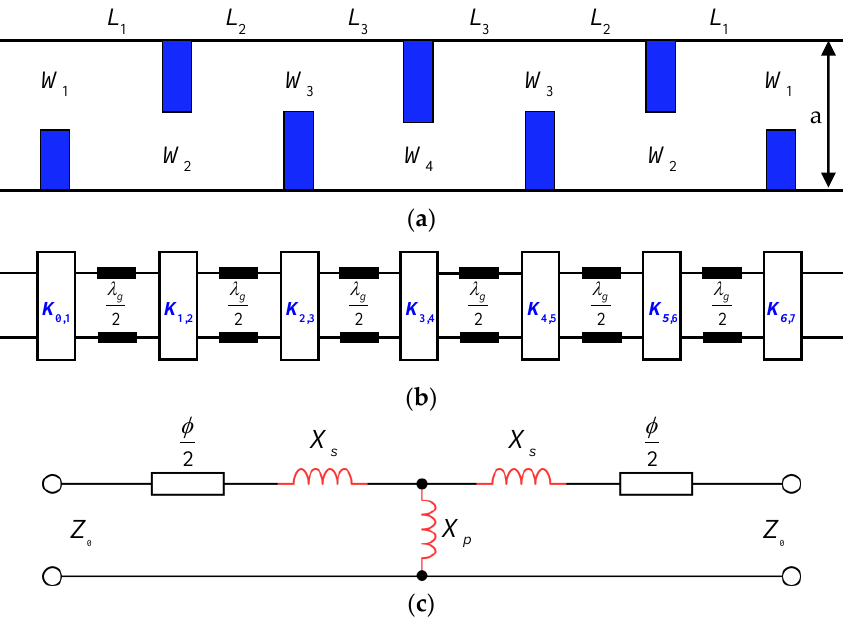
Figure 1. ( a ) Top view of the proposed 6th order waveguide filter with asymmetric irises; ( b ) Equivalent circuit of the filter in terms of impedance inverters; ( c ) The equivalent circuit of a K